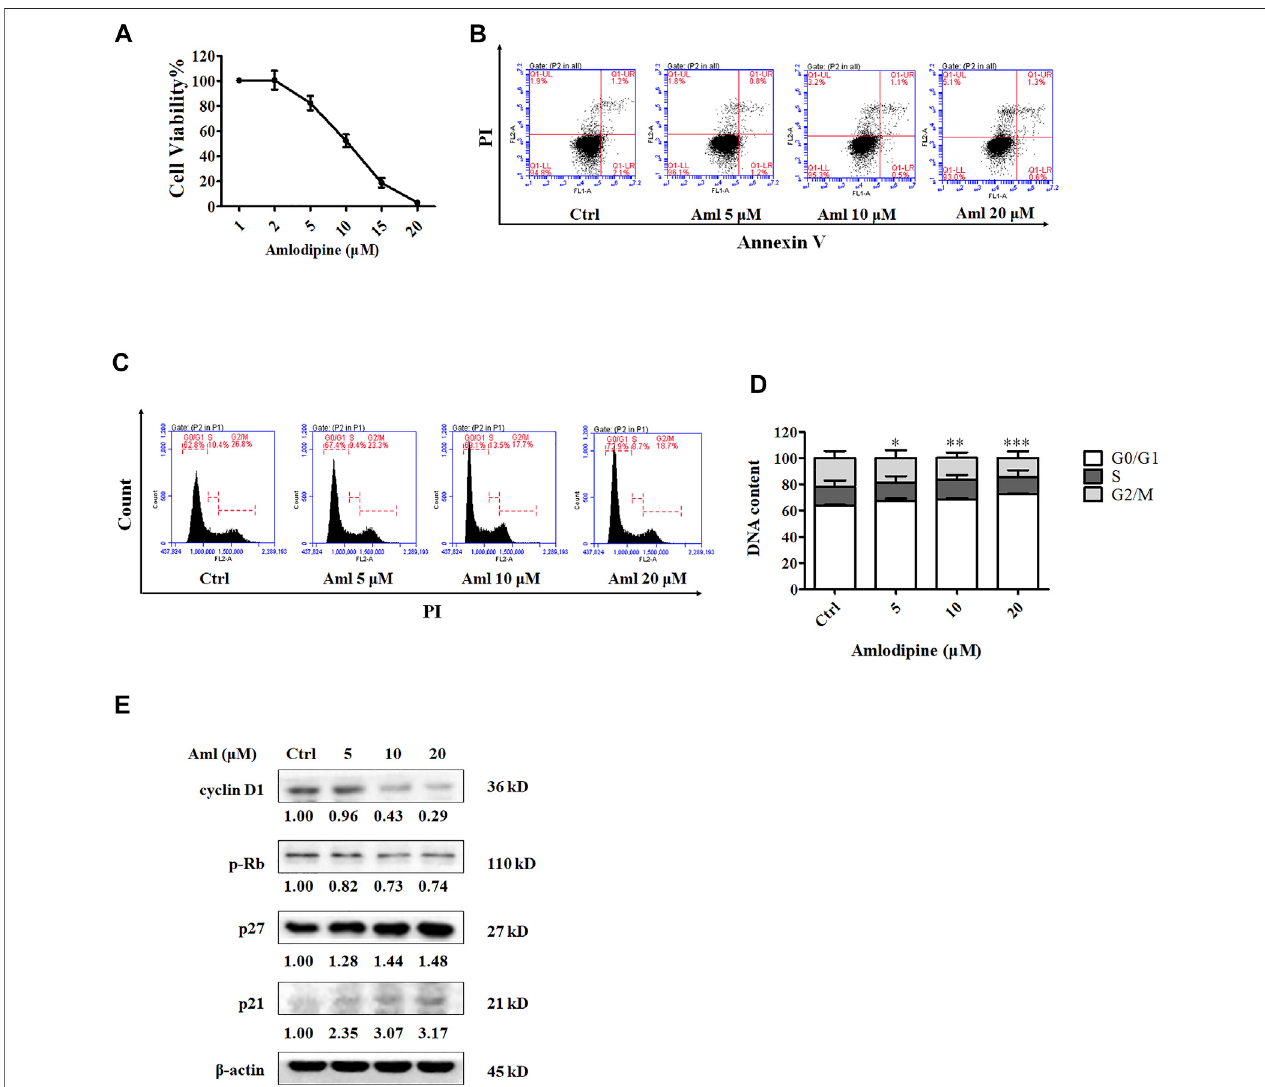
FIGURE 1 | Amlodipine inhibits A549 cell proliferation by blocking the cell cycle G0/G1 phase. (A) Incubation of A549 with various concentrations (1, 2, 5, 10, 15, and 20 μ M) of amlodipine (Aml) for 48 h. The effects of amlodipine on A549 cell proliferation were determined by MTT assay. (B) A549 cells were harvested 48 h after treatment with indicated concentrations of amlodipine, and apoptotic cells were measured by fl ow cytometry analysis. (C) Cells were pre-incubated with different concentrations of amlodipine for 48 h, and the induction of cell cycle arrest was detected by fl ow cytometry analysis. (D) The percentage of total cells at G0/G1, S, and G2/M phases. (E) The expressions levels of cell cycle-related proteins were determined by Western blotting after treatment with amlodipine. Data are presented as mean ± SD of three independent experiments. * p < 0.05, ** p < 0.01 and *** p < 0.001.